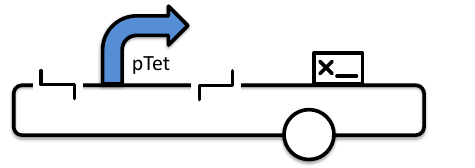
Figure 30: Promoter pTet stored in a circular plasmid. The promoter is prepared for being cut out of the plasmid: it is preceded by a 5’ sticky end restriction site and followed by a 3’ stick end restriction site. In addition, the plasmid has been bar-coded with a signature and has its origin of replication marked.